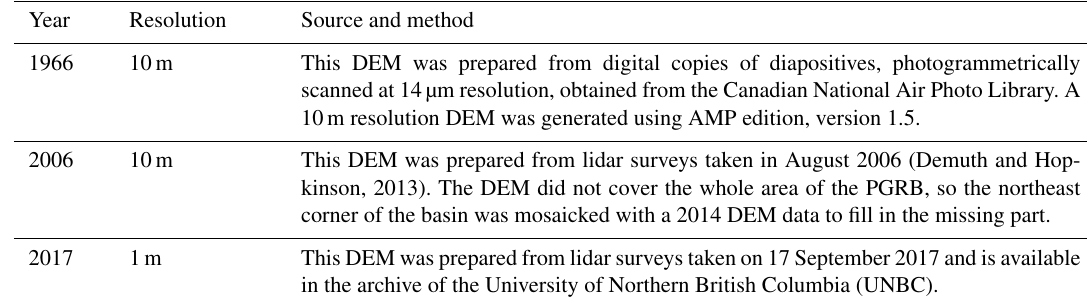
Table 8. DEMs used for co-registration.